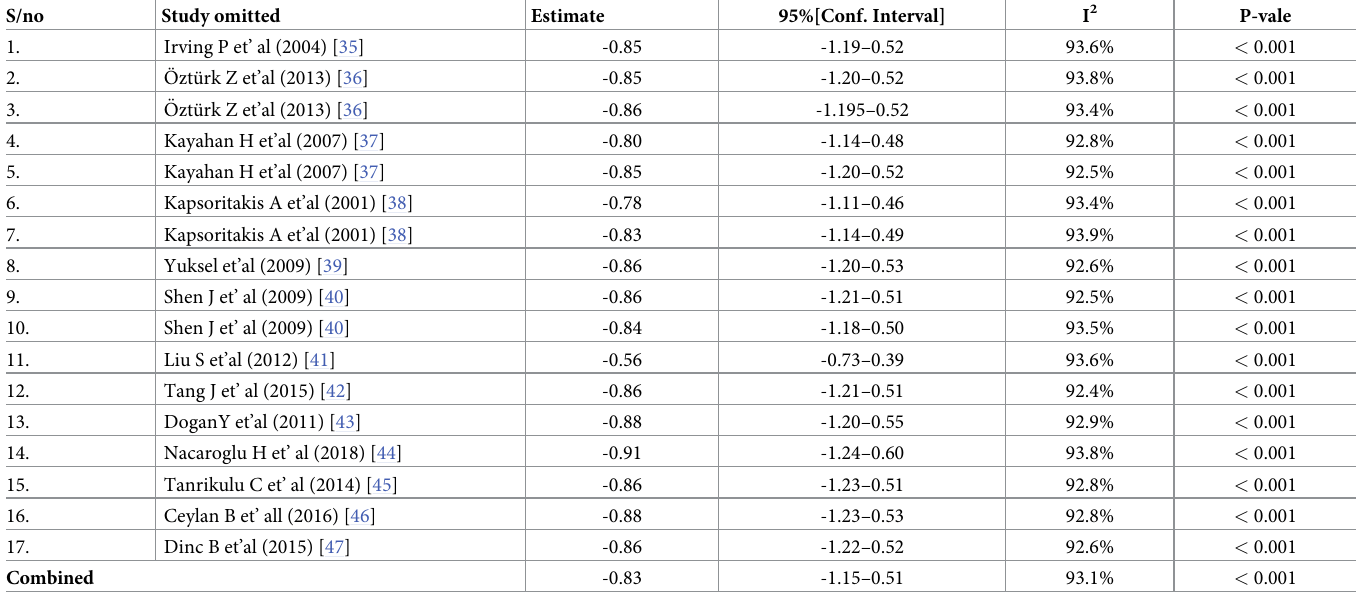
Table 3. Sensitivity analysis of SMD in